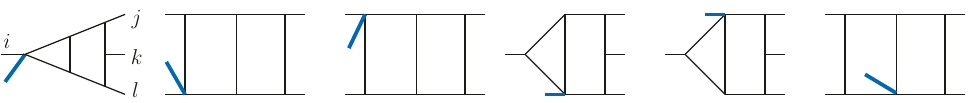
Figure 11. Integral topologies of maximal number of propagators for the planar two-loop form